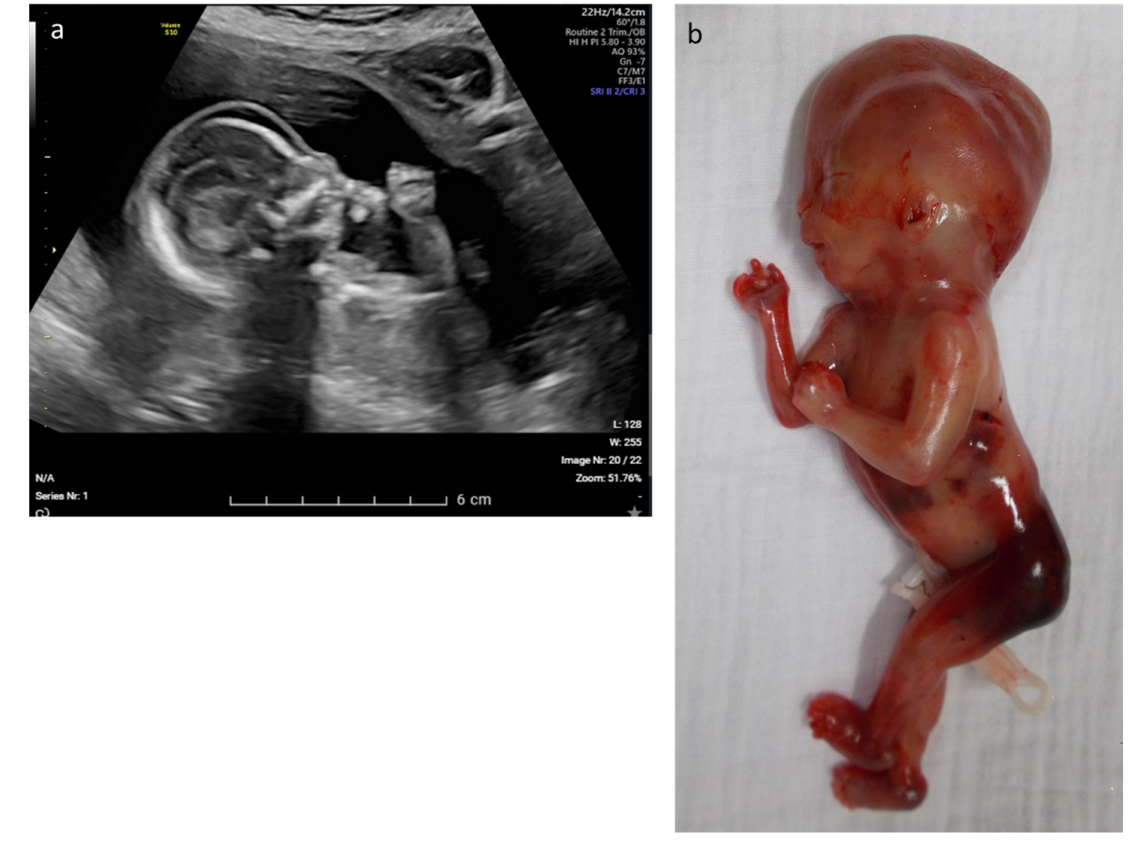
Figure 4. Fetus with a homozygous MUSK variant causing Fetal akinesia deformation sequence 1. ( a ) Ultrasound at 20 weeks, showing subcutaneous edema; ( b ) Clinical picture: rocker-bottom feet and hydrops